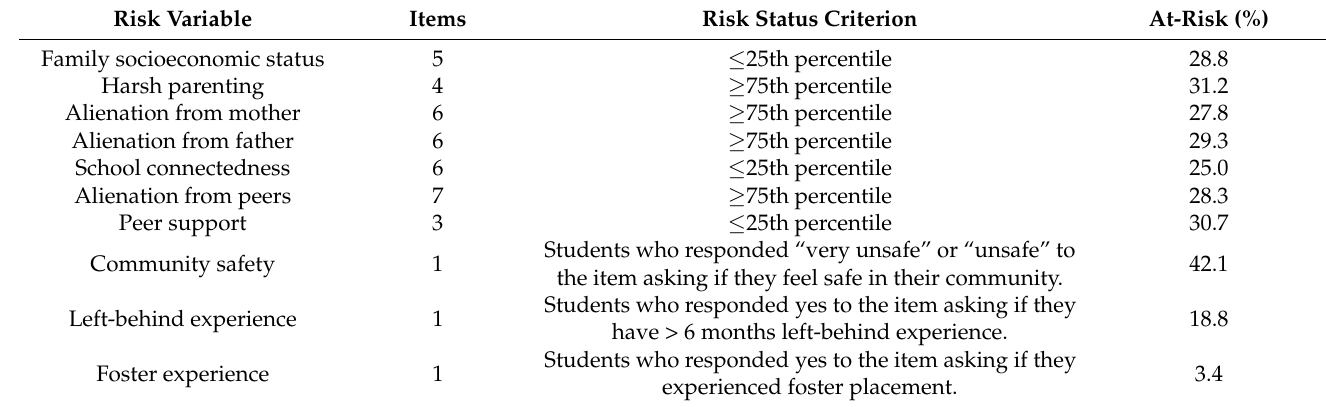
Table 1. Description of risk indicators and the cumulative risk